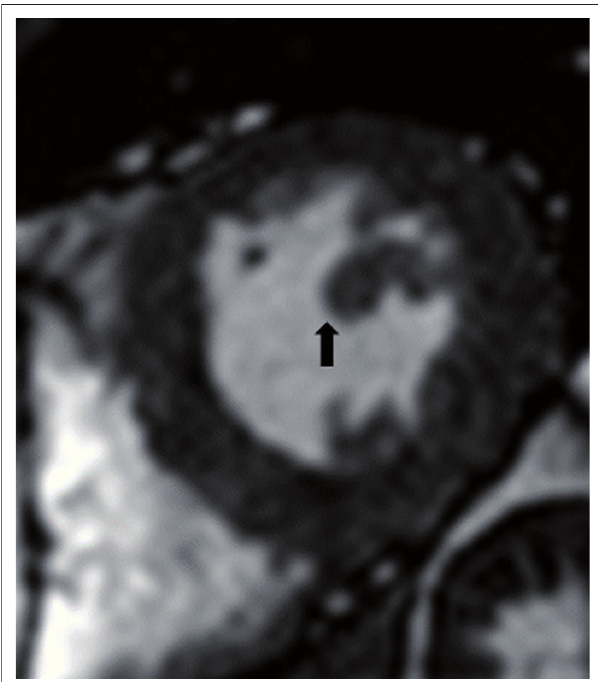
FIGURE 1: Single short-axis cine steady-state free precession (SSFP) image of the LV. The black arrow in the centre of the LV blood pool provides a fixed point to focus the eye upon, which assists in the assessment of the LV wall motion. The degree by which one segment of the LV wall moves towards the arrow (when compared with the rest of the LV segments) simplifies wall motion dysfunction assessment. For video footage, visit https://www.youtube.com/